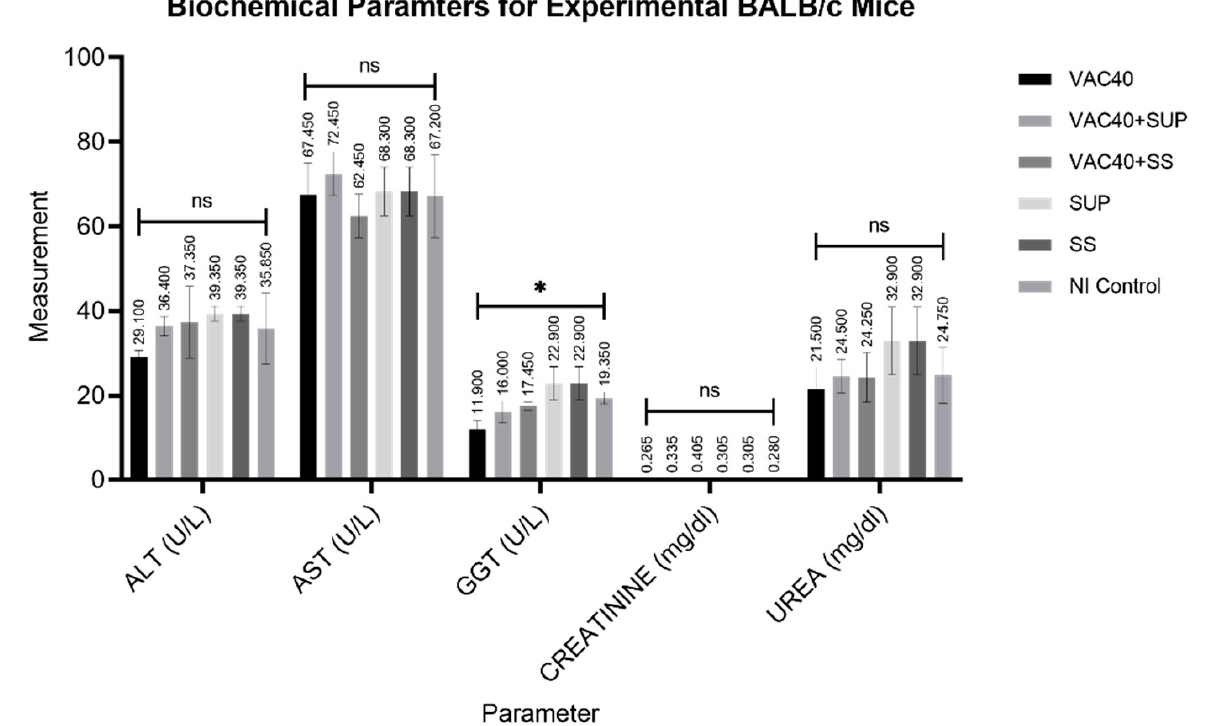
Figure 4. Analyzed results for biochemical parameters of experimental BALB/c mice. VAC40 = vaccine 40 µ L, VAC40 + SUP = vaccine 40 µ L plus commercial selenium supplement, SUP = commercial selenium supplement, VAC40 + SS = vaccine 40 µ L plus sodium selenium, SS = sodium selenite, NI Control = non-immunized group. * Statistical significance ( p < 0.0408). Analysis of Variance (ANOVA) was performed in GraphPad Prism v.9.2 to compare the